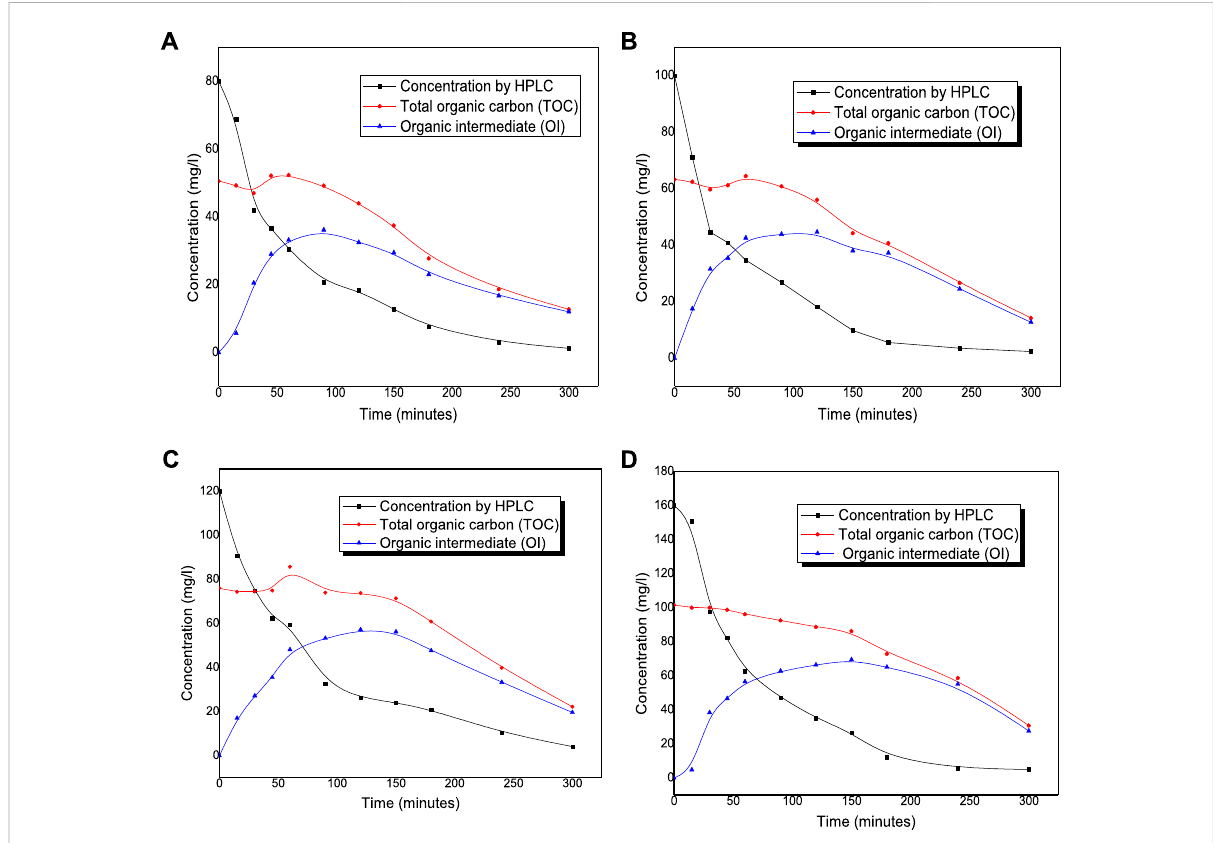
FIGURE 3 Distribution pro fi le of ACET degradationfrom theexperimental data followedby HPLC and of the mineralization byTOC also shows the curves oftheestimatedIOgenerationandconsumptionobtainedbymassbalances. (A) C ACET =80 mg/l, (B) C ACET =100 mg/l, (C) C ACET =120 mg/l,and (D) C ACET =160 mg/l.Inallcases,thedegradationconditionswereasfollows:reactionvolume=250 ml;oxygenconcentration=100 cm 3 /min;catalyst mass = 2 gr/l; four commercial visible light lamps were